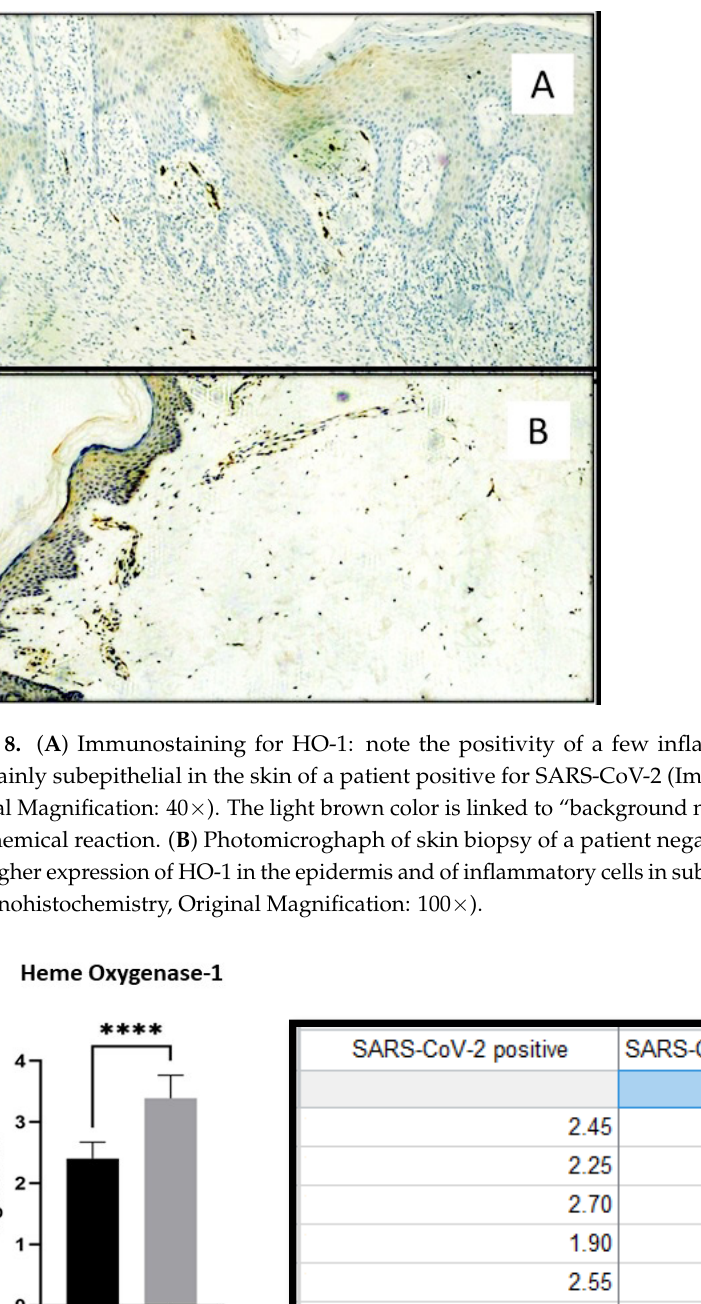
Figure 7. Different levels of immunoexpression also for TIM-3 in the two populations: note that, with the same lymphocyte population (CD4 and CD8 not statistically different), the lymphocytes present in the study arm of SARS-CoV-2 positive patients were immunolabeled for TIM-3 more than in the second group ( p value: <0.0001). **** statistic significative.